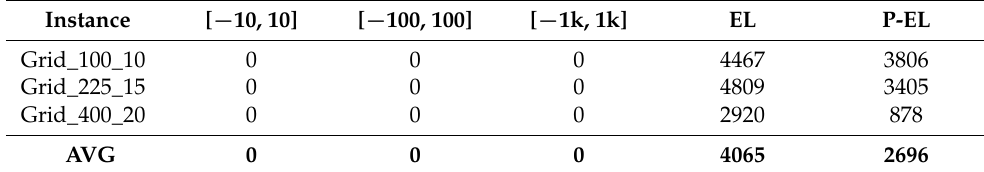
Table 3. Objective function value for the grid instances.